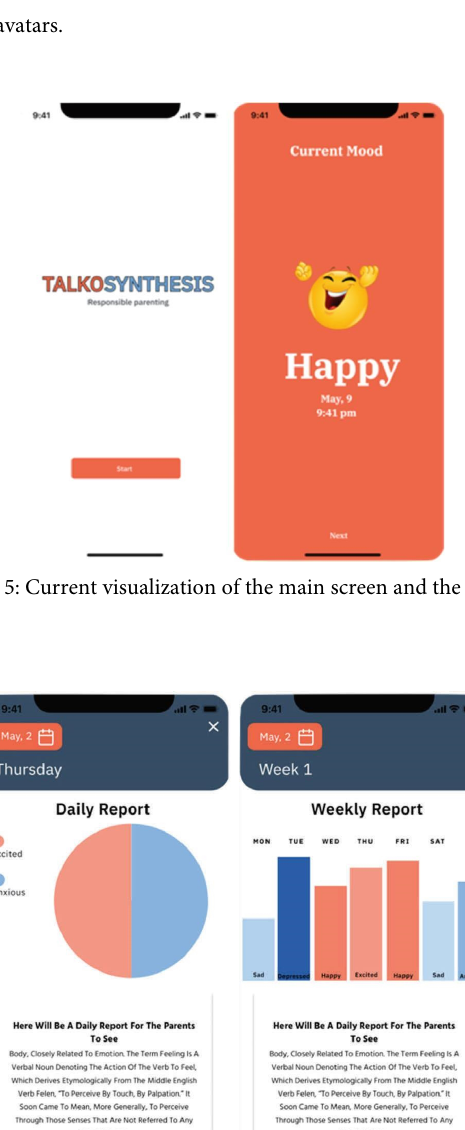
Figure 3: Selectable user avatars.